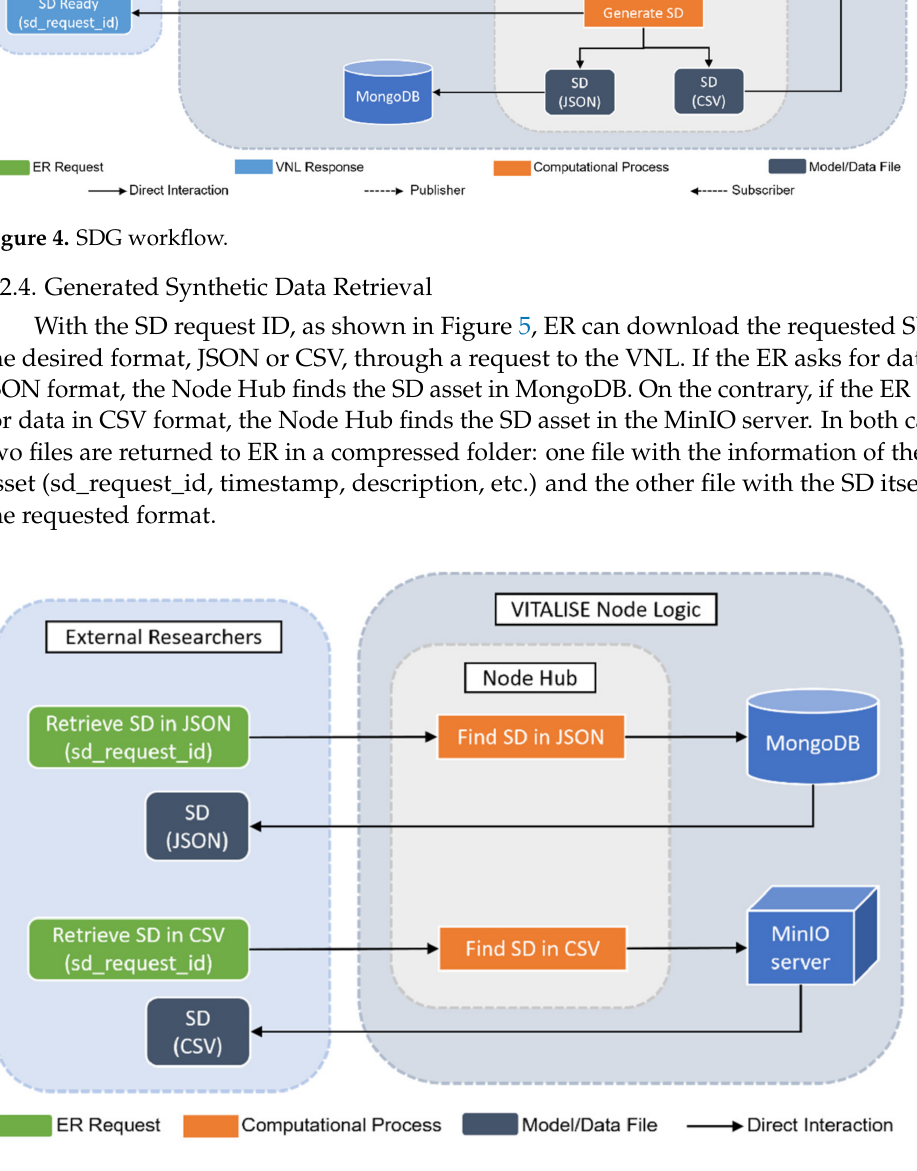
Figure 5. SD downloading